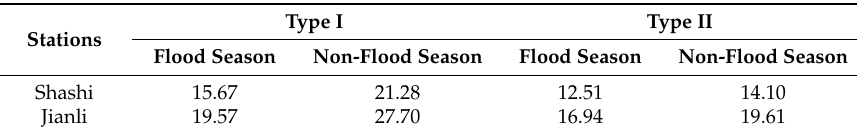
Figure 7. Lateral distribution of contribution ratios of the two near-bed points, ( a ) for Shashi hydrological station, and ( b ) for Jianli hydrological station. R 0 = contribution ratio of the two near-bed points, B i = lateral distance of measured vertical lines from the left bank, and B avg = maximum width of the cross section. Table 3. Vertical averaged R 0 -values of data measured after TGD dam operation.